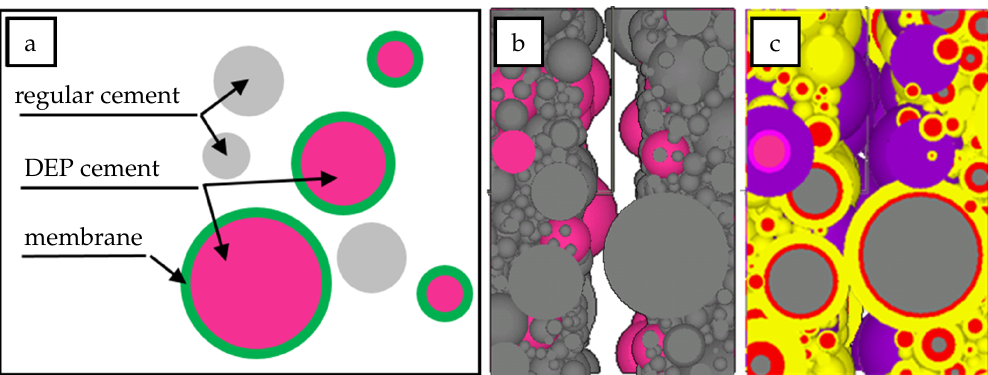
Figure 2. Self-healing with Dissoluble Encapsulated Particles (DEP): ( a ) Schematic representation of regular cement blended DEP cement [12]. ( b ) Initial state of microstructure by vol. − 10% cement replacement by DEP [12]. ( c ) A high pH value will cause the DEP capsule to rupture, the healing agent will be released and a special hydration reaction with accompanying volume expansion will begin